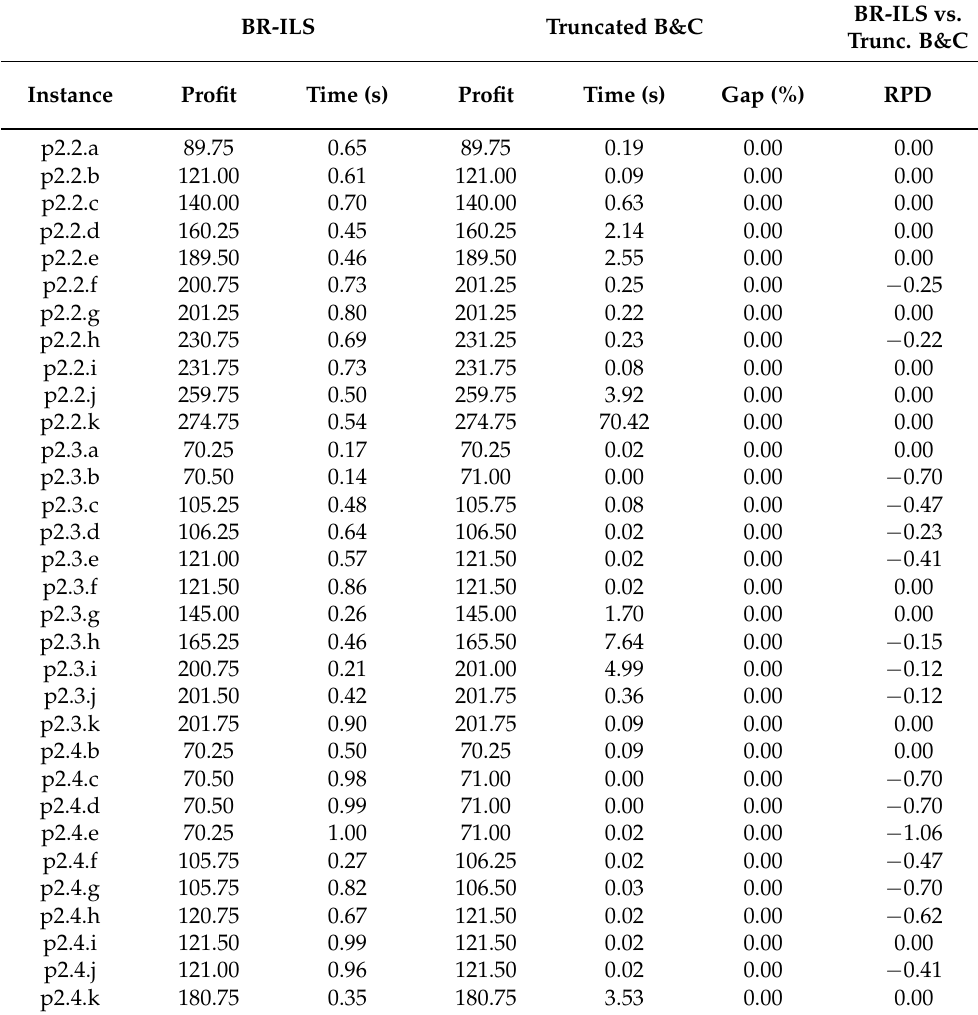
Table 3. Results given by the BR-ILS and the truncated B&C ( F 2) models for p 2